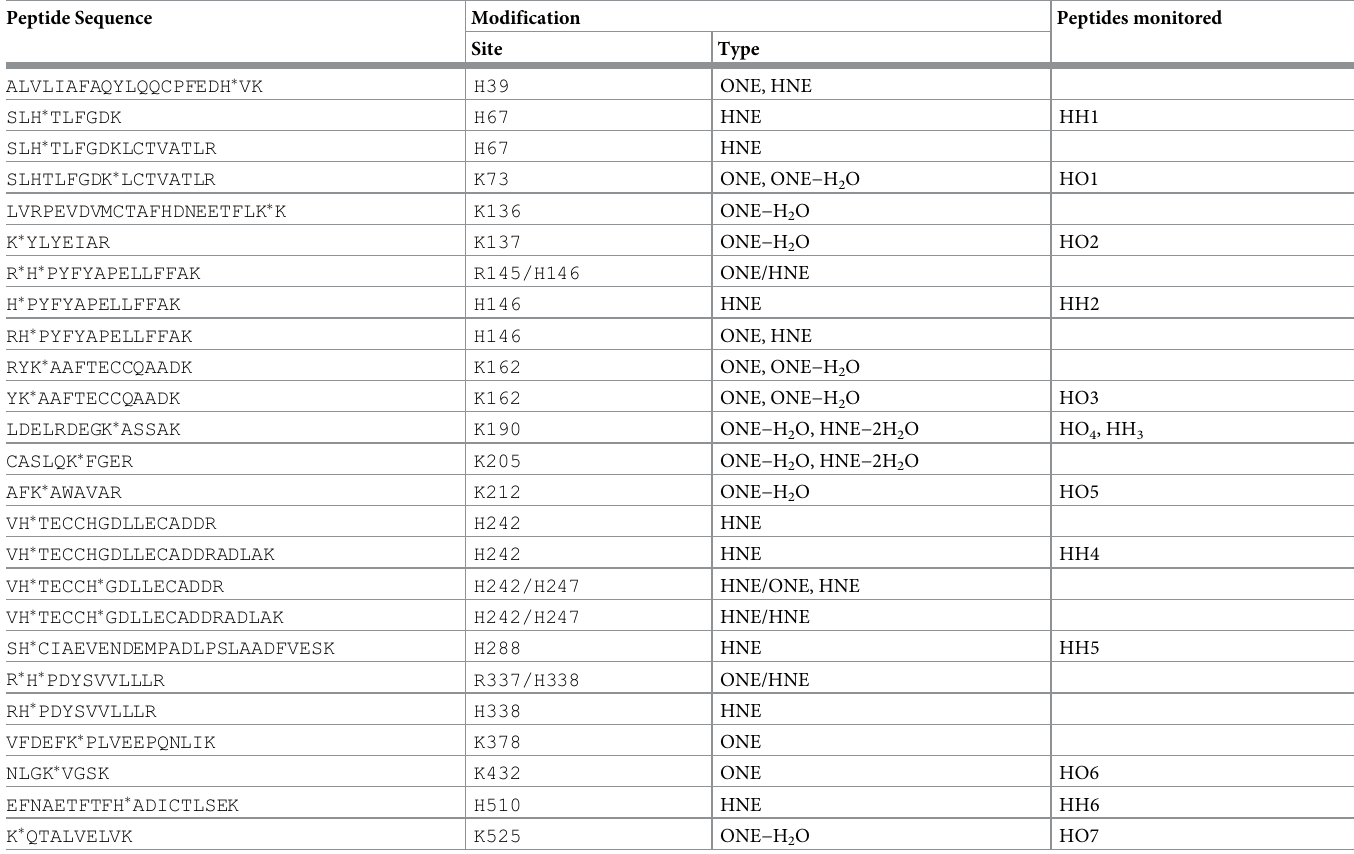
Table 1. List of ONE- and HNE-modified HSA peptides identified from the reaction of HSA with 13-HPODE in the presence of AscA. Peptide